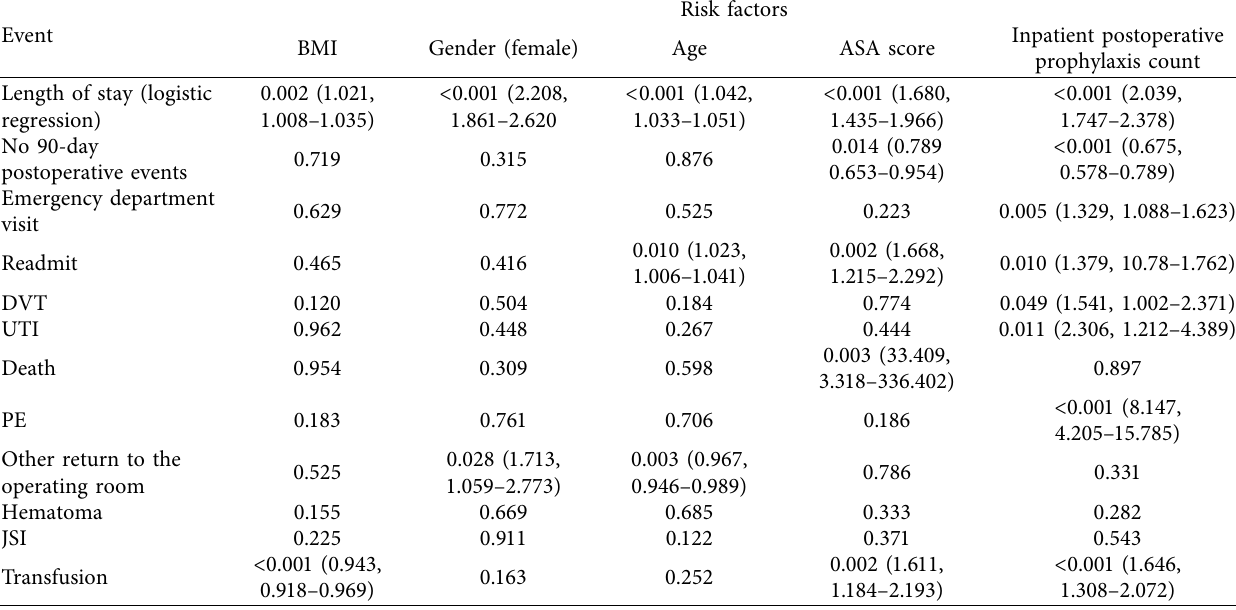
Table 4: Logistic regression analysis on increasing the number of VTE medications